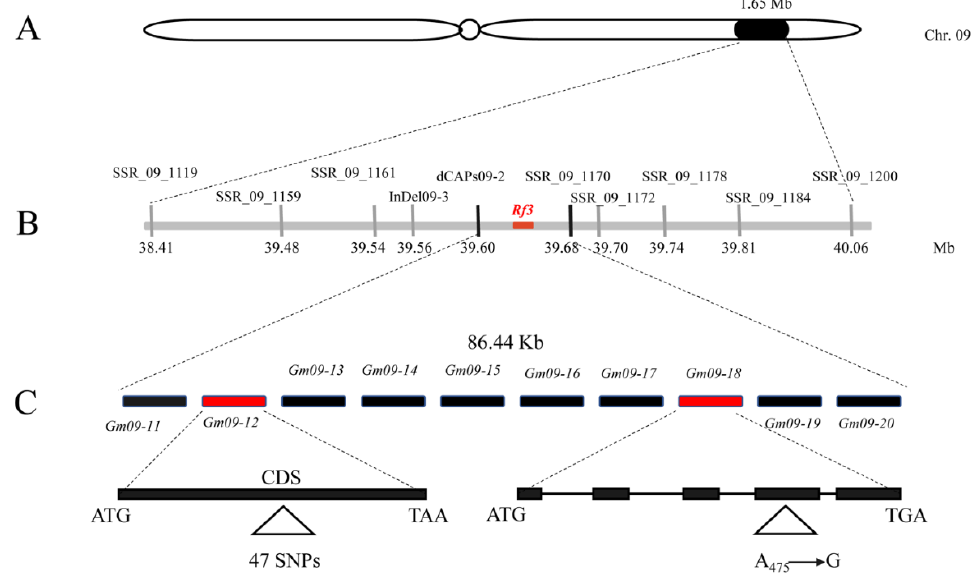
Figure 4. Physical mapping of the Rf3 locus. ( A ) The Rf3 locus is located on chromosome 9 according to BSA-Seq and primary mapping. ( B ) Fine mapping of the Rf3 region on chromosome 9. The Rf3 locus is mapped to an 86.44 Kb region between the markers dCAPs09-2 and SSR_09_1170. ( C ) The 86.44 Kb region containing 10 putative genes according to the Williams 82 reference genome. Gm09-11–Gm09-20 indicate Glyma.09G171100–Glyma.09G172000 , respectively.